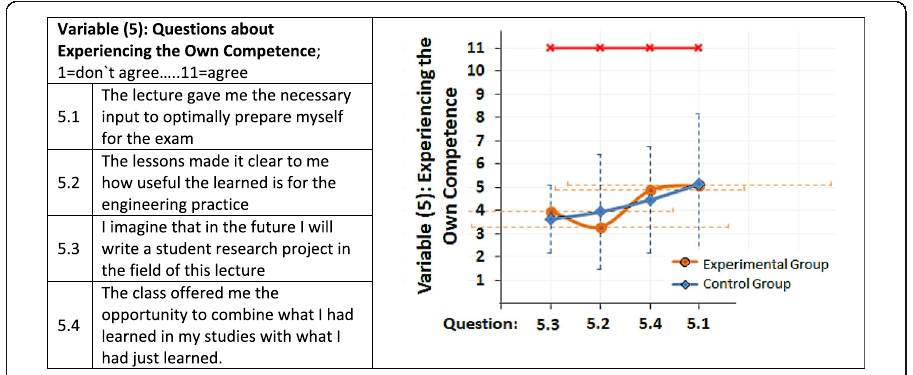
Fig. 7 Post-Test results for Variable (5). Not significant (p > .05) over all questions, horizontal line shows theoretical maximum, dotted lines indicate scattering of